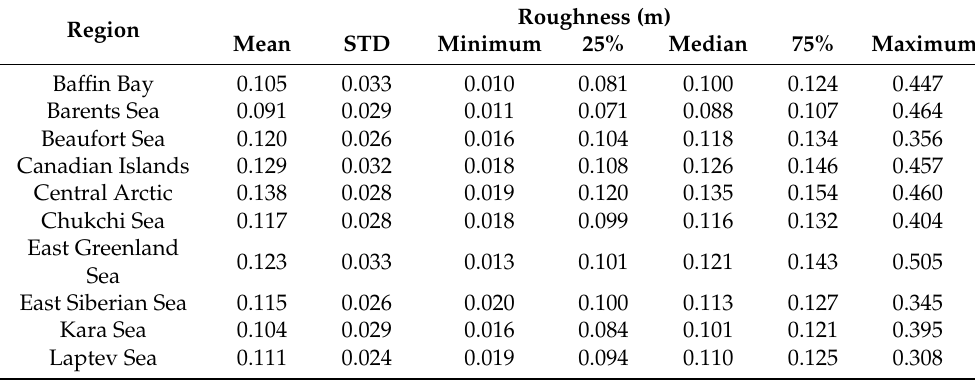
Table 4. A table showing surface-roughness distributions grouped by Arctic region, for April 2000–2020. Arctic regions are as defined in the NSIDC Regional Mask, illustrated in Figure A1.